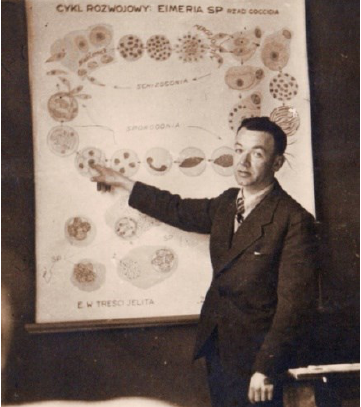
Figure 4. Franciszek Pliszka (1909–1956) teaching fish diseases in 1943. He received